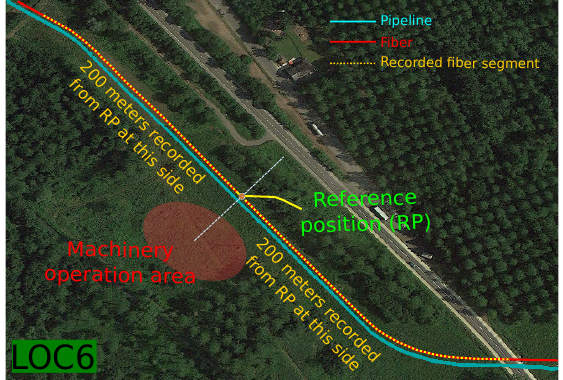
Figure 5. Recording scenario: real example at LOC6, taken from